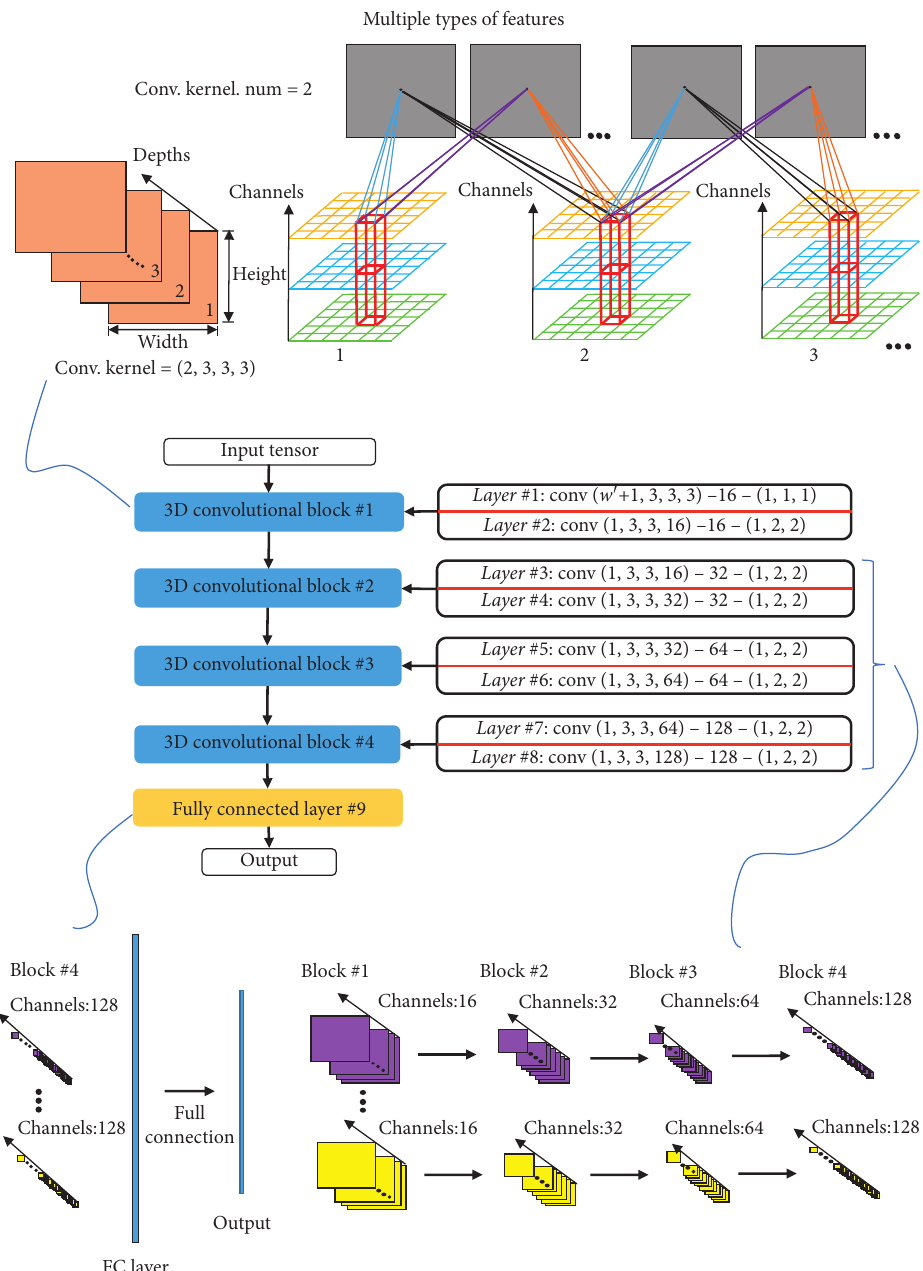
Figure 4: Designed 3D-CNN